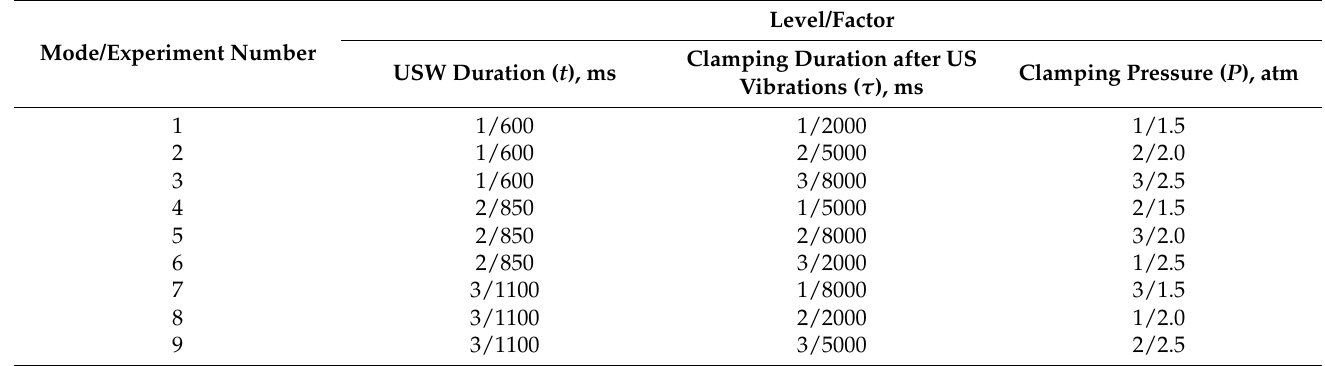
Table 1. The combination of the USW parameters and their levels (according to the Taguchi table in L9 format for a three-factor experiment).